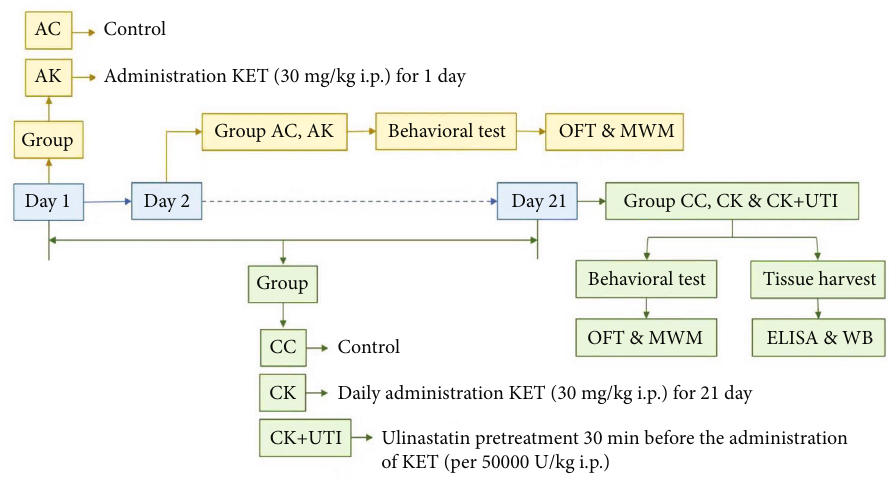
Figure 1: A brief schematic representation of experimental protocols.